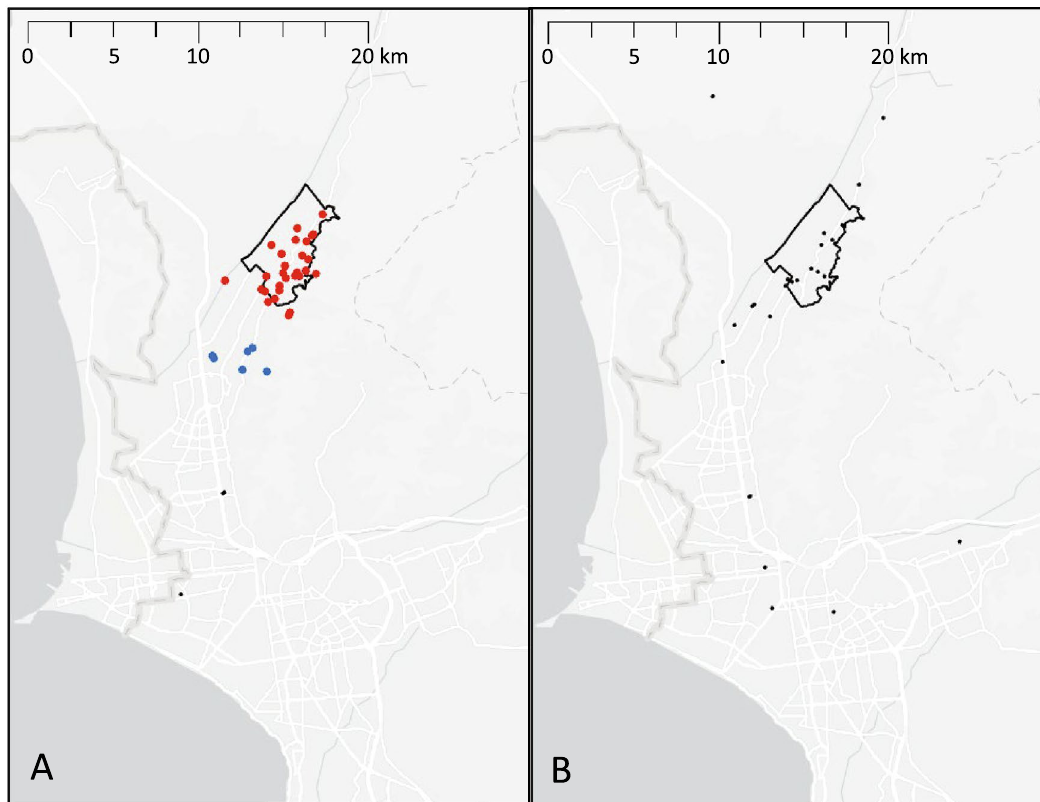
Figure 3. Density-based clustering of locations where participants reported having socialized routinely during the past 6 months. Each dot represents a location reported by a study participant, with colors representing clusters and black dots representing non-clustered locations. The black outline indicates the study area. ( A ) Among TB patients, locations clustered mainly within the study area (red dots) with a smaller cluster in a neighboring district (blue dots). ( B ) No clusters were identified for control group participants. Map was created by MBB using ArcGIS Pro Version 2.8.0 (Environmental Systems Research Institute, Redlands, California, USA).